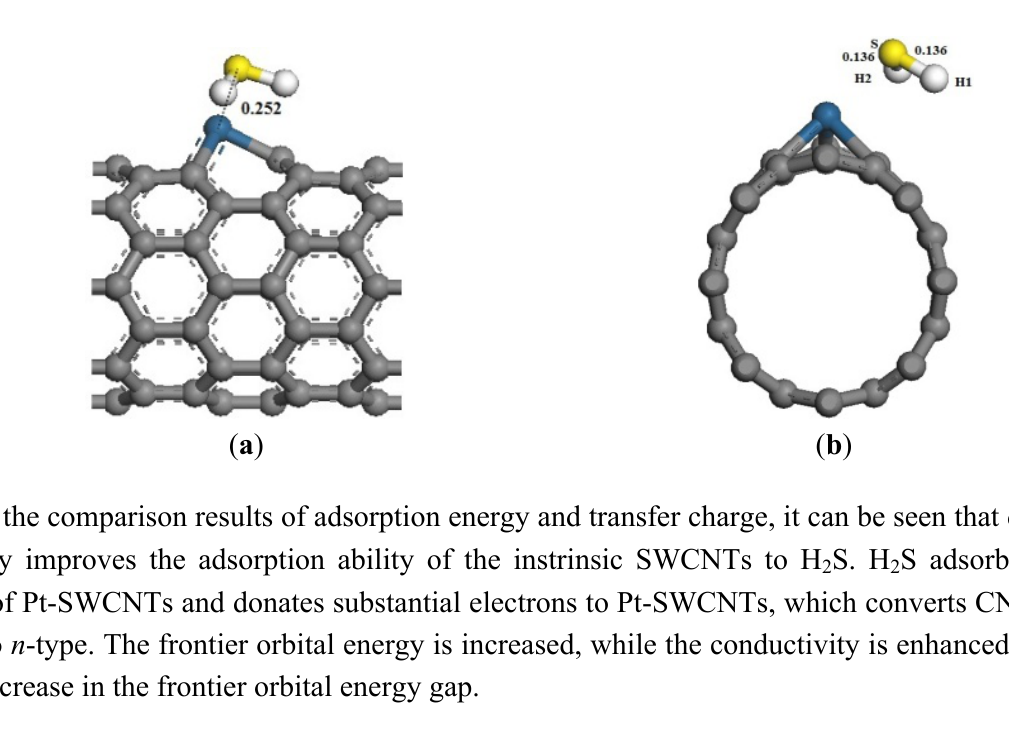
Figure 5. Structural model of H ( b ) side view.